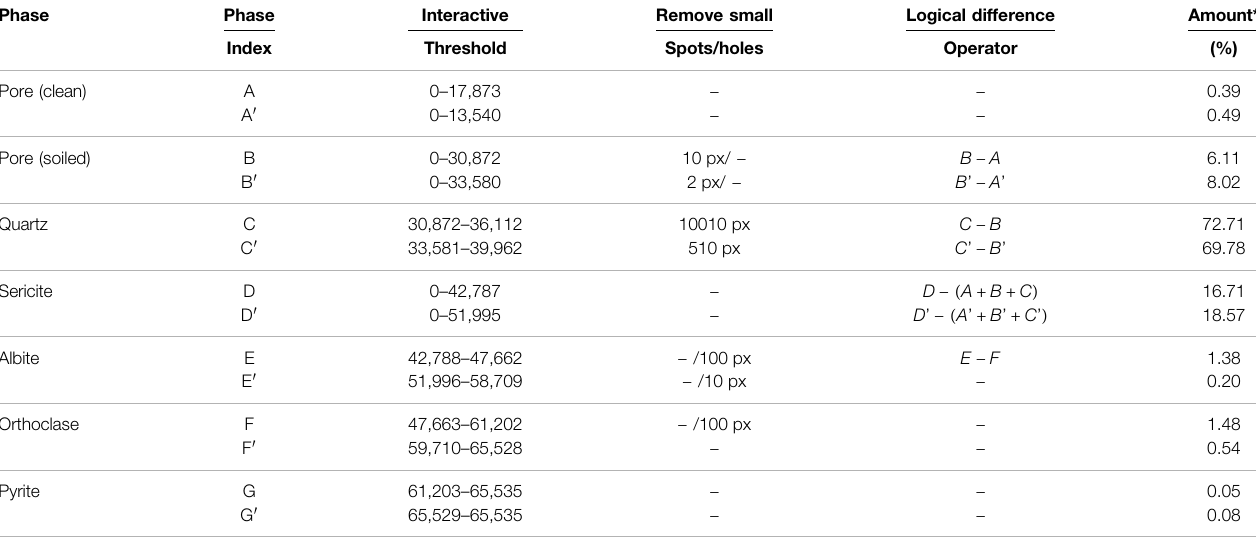
TABLE 3 | Phase segmentation matrix with applied settings and derived phase quantities for the subvolumes of Ruhr sandstone 800 3 and 400 3 voxel.